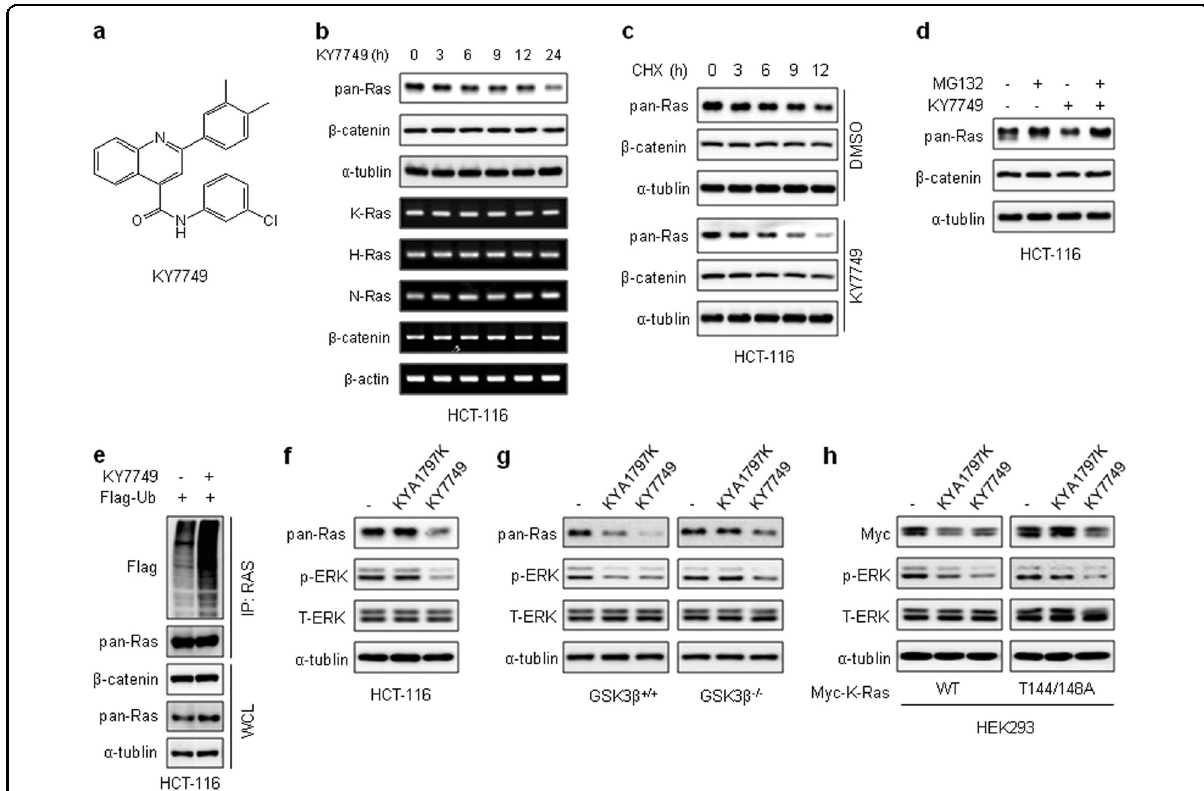
Fig. 2 The effects of KY7749 on polyubiquitination-dependent proteasomal degradation of pan-Ras. a The chemical structure of KY7749. b Immunoblot and reverse transcription polymerase chain reaction (RT-PCR) analyses of HCT-116 cells treated with 25 μ M of KY7749 for the indicated time periods. c Immunoblot analyses of HCT-116 cells co-treated with 50 µg ml − 1 of cycloheximide (CHX) and 25 μ M of KY7749 for the indicated time periods. d Immunoblot analyses of HCT-116 cells treated with 25 μ M of KY7749 with or without 20 μ M of the proteasomal inhibitor MG132 for 4 h. e Immunoblot analysis of polyubiquitination-mediated proteasomal degradation of pan-Ras in HCT-116 cells transfected with Flag-Ubiquitin and then treated with 20 μ M of MG132 with or without 25 μ M of KY7749 for 24 h. f Immunoblot analysis of HCT-116 cells treated with 25 μ M of KY7749 or KYA1797K for 24 h. g , h Immunoblot analysis of MEF GSK3 β + / + or GSK3 β − / − cells ( g ) and HEK293 cells transiently overexpressing K-Ras WT or K- Ras T144/148A ( h ) and treated with 25 μ M of KY7749 or KYA1797K for 24 h. WCLs or immunoprecipitated samples were immunoblotted with antibodies against the indicated proteins ( b – h